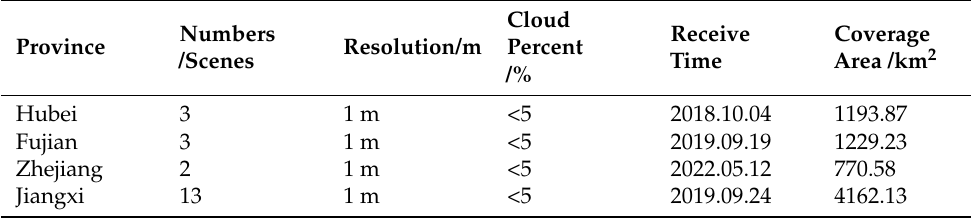
Table 1. Remote sensing image data details.